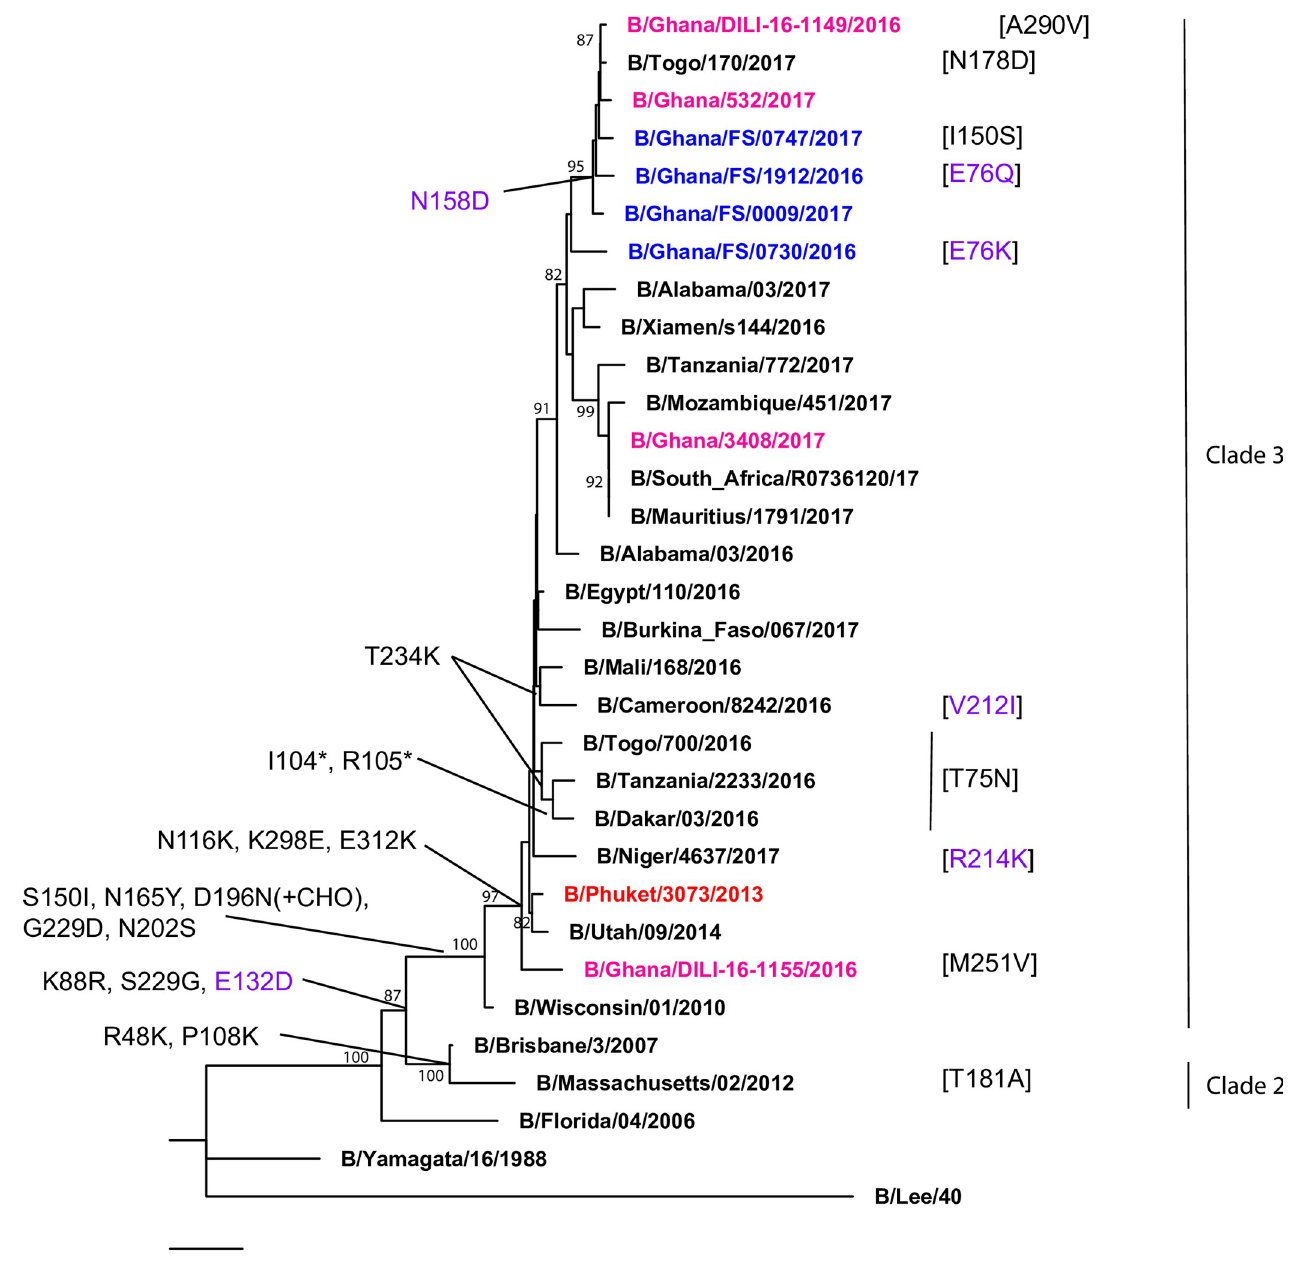
Fig 4. Phylogenetic analysis of influenza B Yamagata lineage using the HA genes. Bootstrap values over 80% are indicated on the tree. Red represents the WHO vaccine candidate virus genome, pink represents reference Ghanaian specimens sequenced at the Francis Crick Institute, blue represents the sequences we identified, green represents the deletion sub-group, Amino acid changes in black represent those within HA1, with violet representing changes in the HA2. substitutions within the HA1 gene. Only one specimen, Influenza B/Ghana/FS/0747/2017 had an additional I150S amino acid substitution within the HA1 gene. All of the sequences identi- fied, and Ghanaian reference sequences (B/Ghana/DILI-16-11149-2016 and B/Ghana/532/ 2017) showed diversity at position I/T198T of the HA1 gene compared to the vaccine strain. A majority (83%) of the sequences in this report, including the two Ghanaian reference